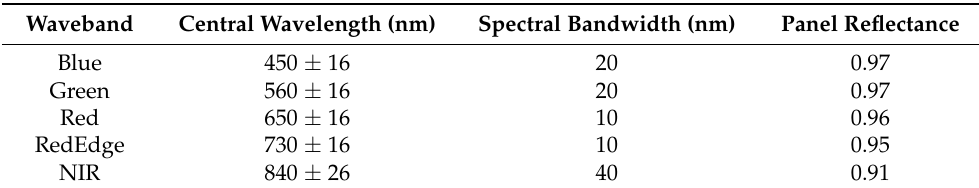
Figure 2. UAV system: DJI P4M UAV ( upper ), image sensor ( lower-right corner ) and reflectance panel ( lower-left corner ). Table 1. Band parameters of the multispectral sensor for P4M.